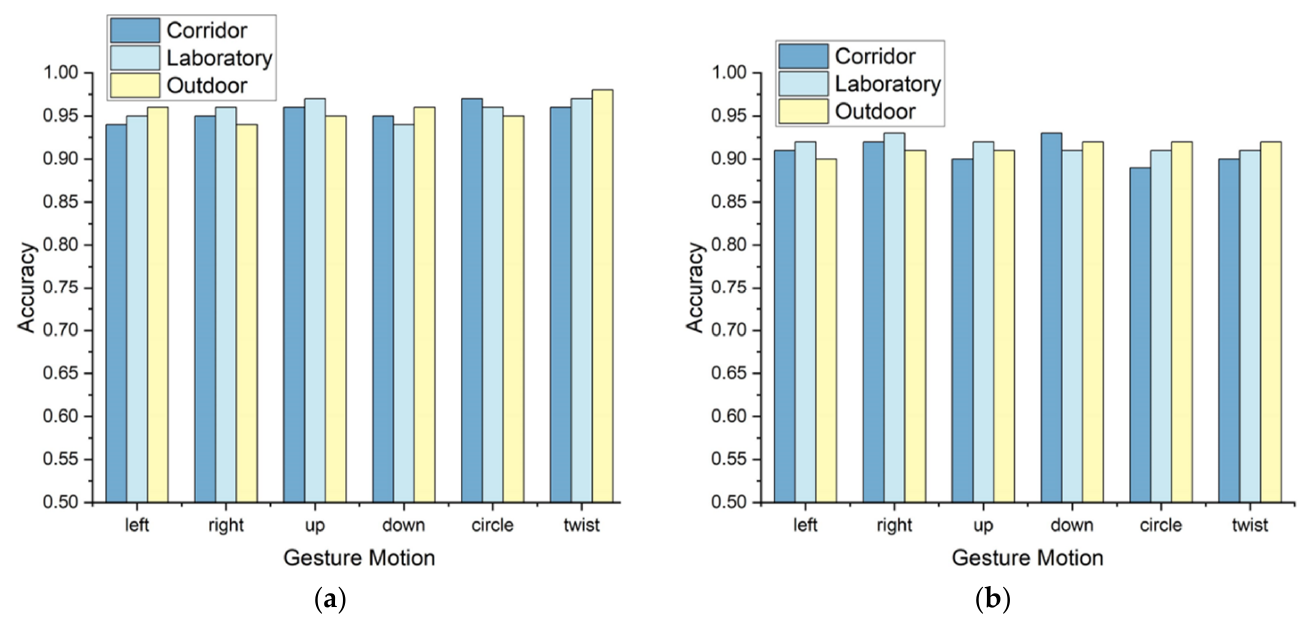
Figure 14. Comparison of recognition accuracy in different environment. ( a ) Recognition rate under 77 GHz bandwidth. ( b ) Recognition rate under 24 GHz bandwidth.